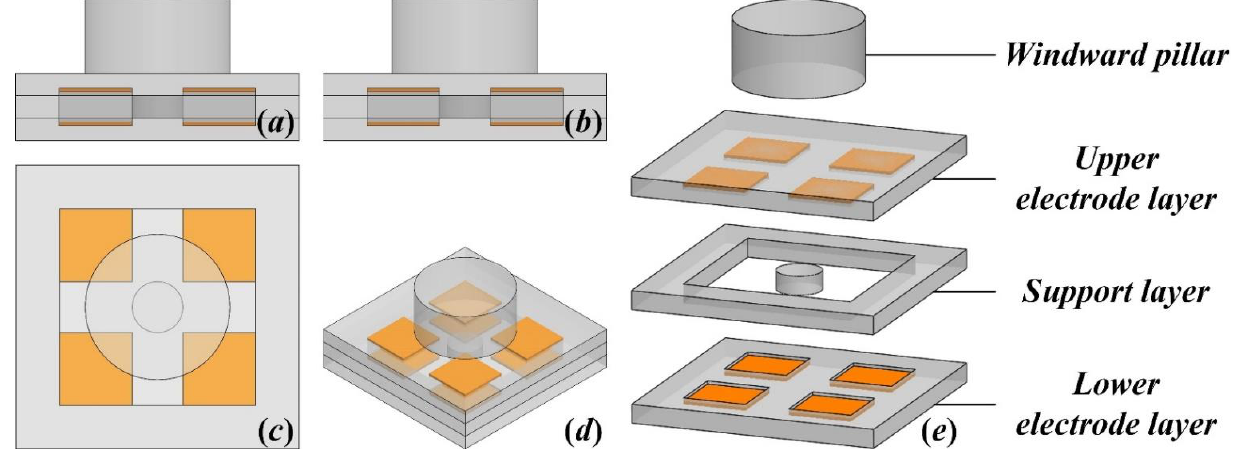
Figure 1. Schematic diagram of the proposed flexible wind sensor: ( a ) main view, ( b ) left view, ( c ) top view, ( d ) isometric view, and ( e ) hierarchical structure view.